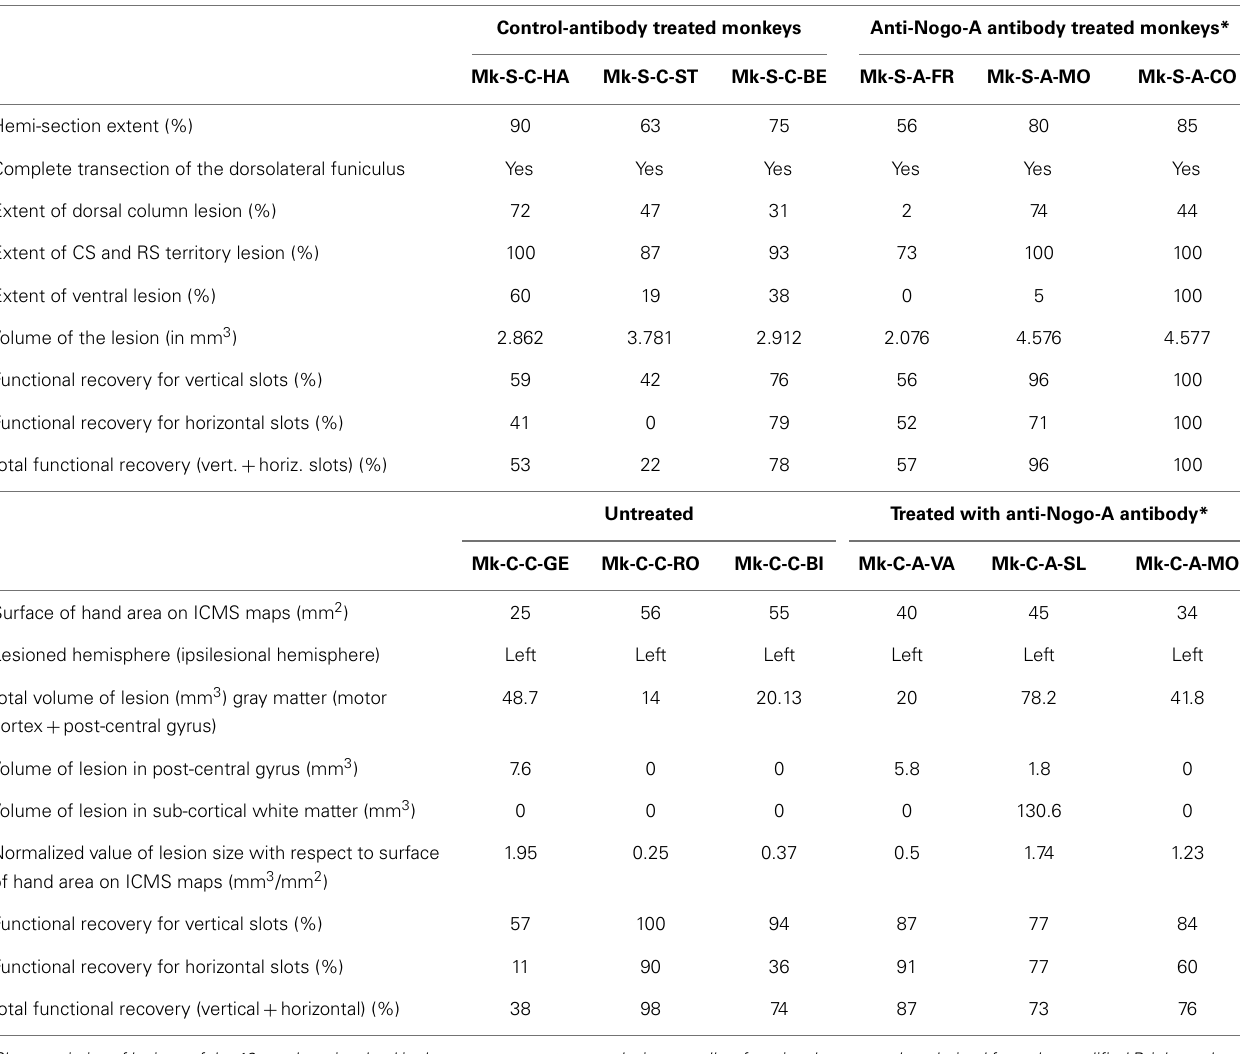
Table 1 | (A) Spinal cord lesion monkeys. (B) Motor cortex lesion monkeys.